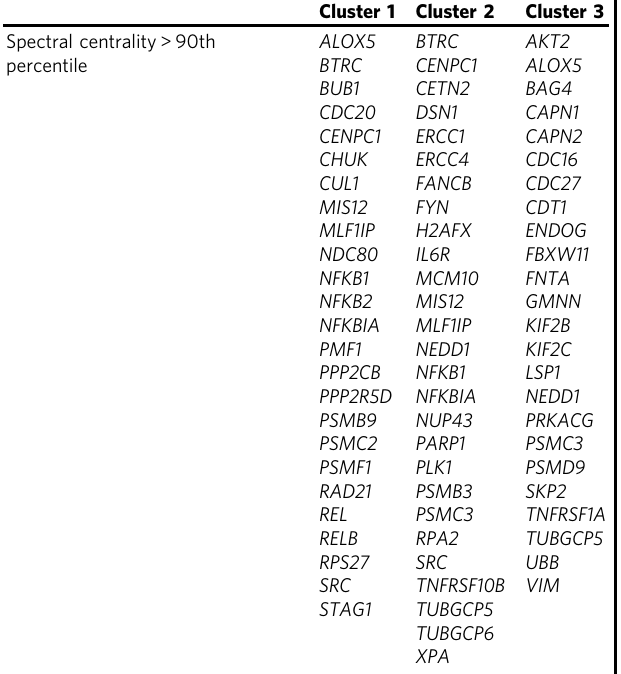
Table 1 Signature genes. List of signature genes for the three tumour clusters